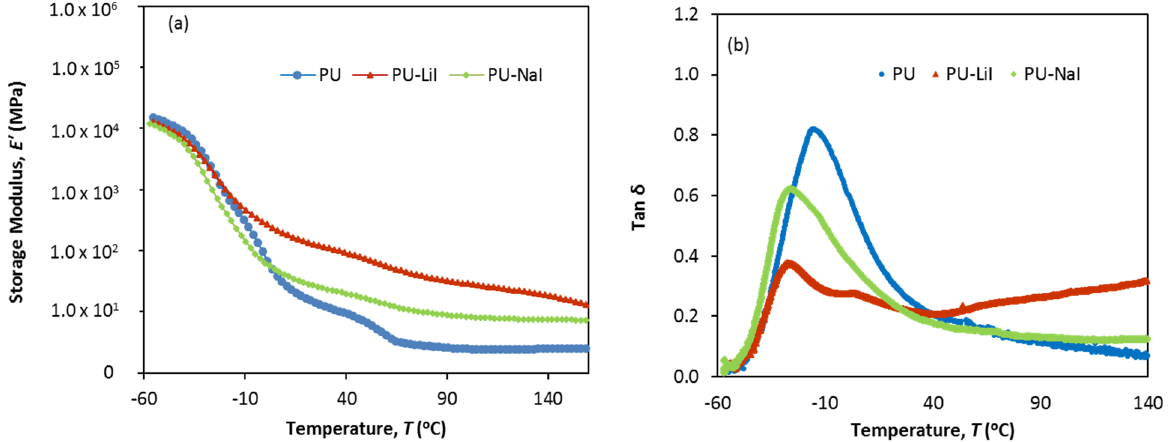
Figure 5. ( a ) Storage modulus, E ' and ( b ) tan δ as a function of temperature of PU, PU-LiI and PU-NaI polymer